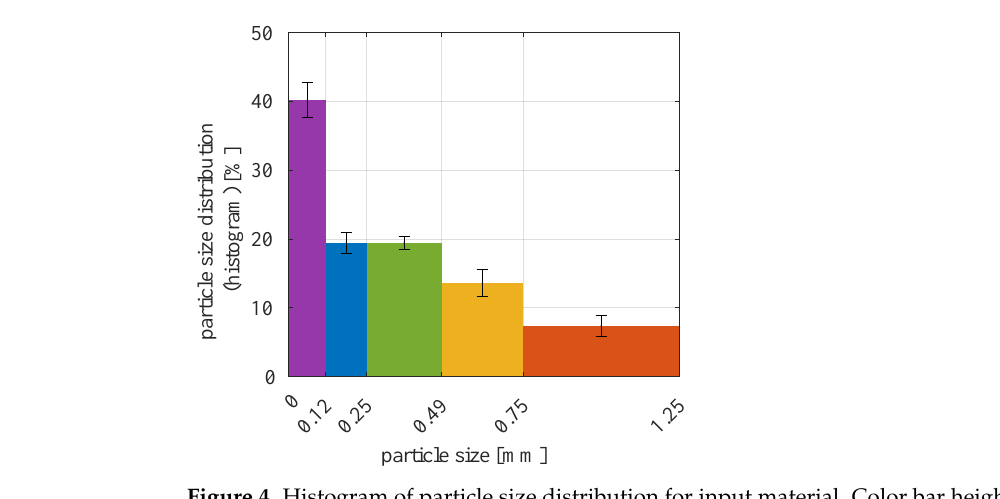
Figure 4. Histogram of particle size distribution for input material. Color bar heights indicate mean values for all experiments and error bars extend to ± 1 × standard